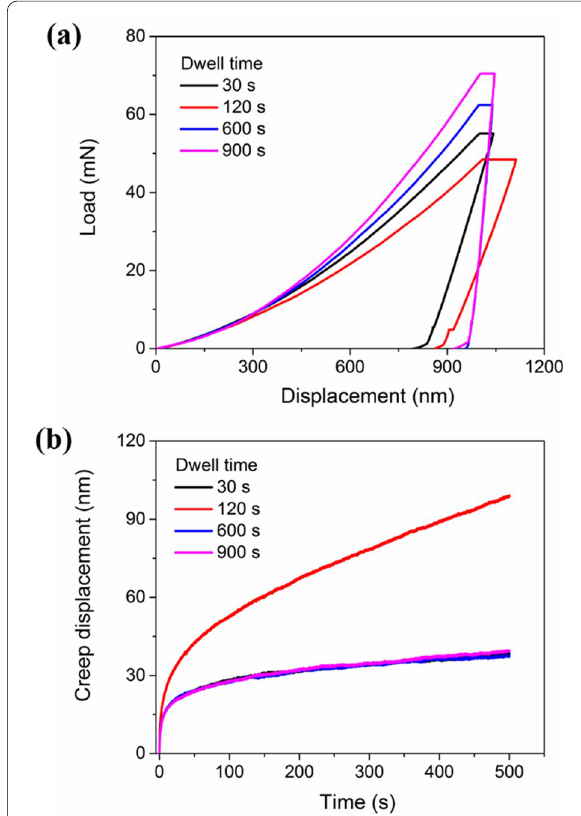
Figure 11 ( a ) representative load-displacement curves and ( b ) creep curves measured in the fracture edge of the CF-tested specimens with different dwell times